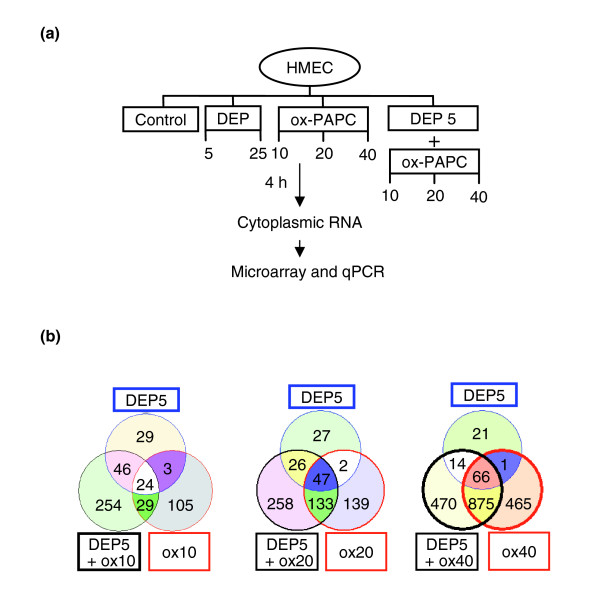
DEP and ox-PAPC induce a large number of genes in HMEC. (a) Experimental protocol. HMEC were treated in triplicate wells with DEP, ox-PAPC, or DEP + ox-PAPC at the various concentrations shown. Cells were harvested at 4 h and cytoplasmic RNA prepared. Illumina microarrays were run and the data confirmed by qPCR analysis of selected genes. (b) Venn diagrams of upregulated genes. The numbers of genes that were significantly upregulated (> 1.5-fold, p < 0.05) over controls (no treatment) by the various treatment are shown. The left Venn diagram summarizes the number of genes induced by DEP 5 μg/ml (DEP5), ox-PAPC 10 μg/ml (ox10) and DEP5 + ox10. The middle Venn diagram shows the number of genes induced by DEP5, ox-PAPC 20 μg/ml (ox20) and DEP5 + ox20. The right Venn diagram summarizes the number of genes induced by DEP5, ox-PAPC 40 μg/ml (ox40) and DEP5 + ox40. The total number of genes induced by a particular condition can be found by adding all values displayed within the circle corresponding to that condition. Values displayed in the circle intersections indicate the number of genes induced in common by the intersecting conditions.